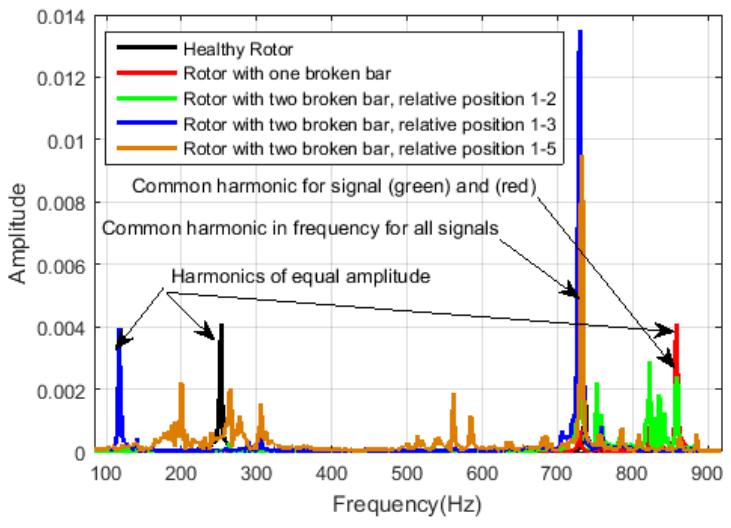
Figure 19. A comparison for all signals spectra after the noise-reduction process.